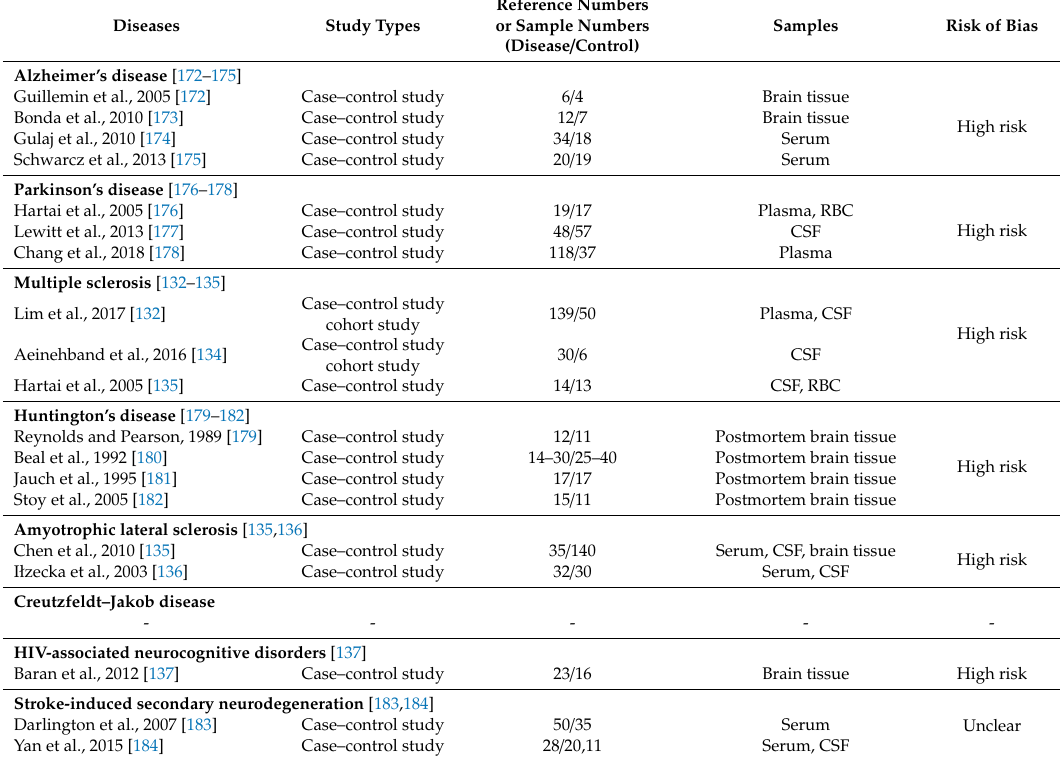
Table A2. Studies of kynurenine status included for systematic review synthesis, study designs, and risk bias assessment.